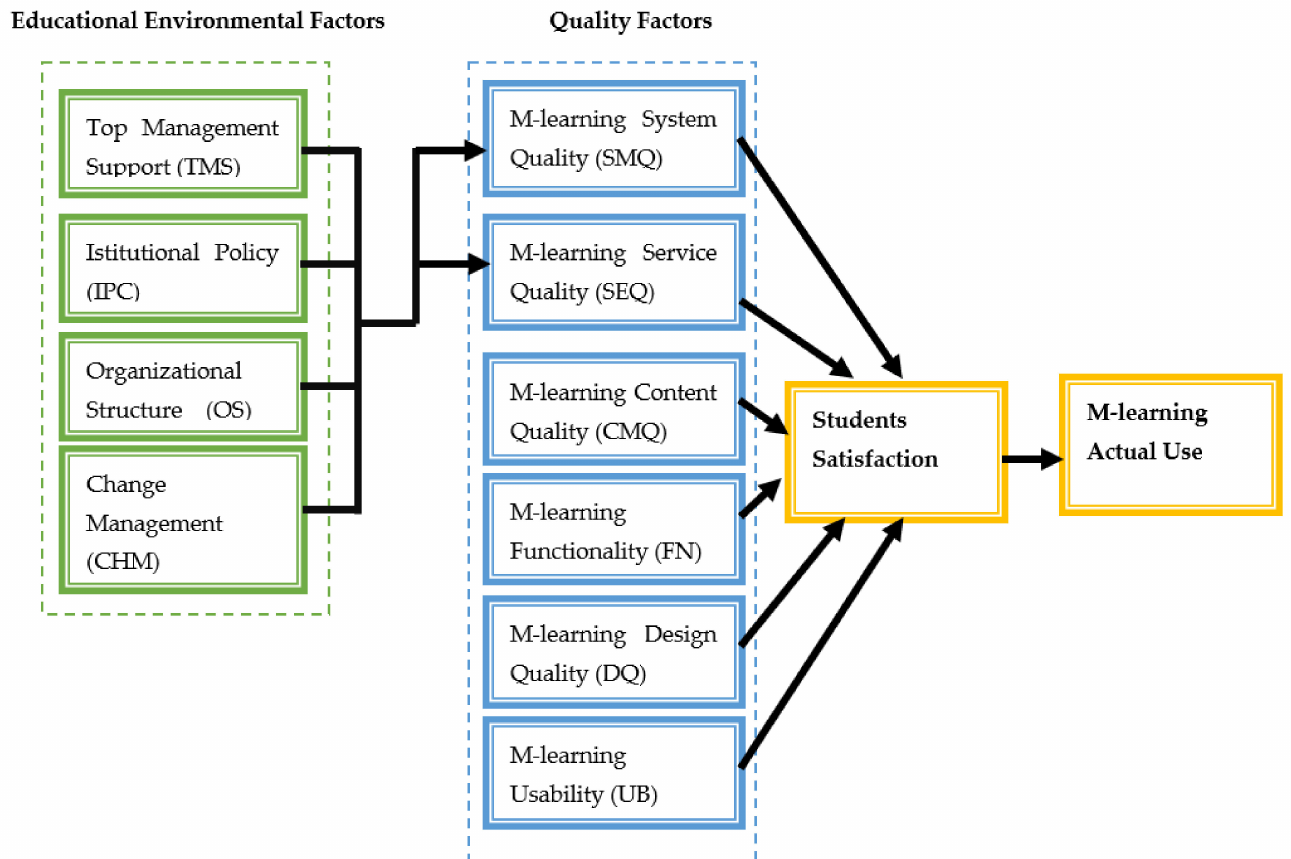
Figure 3. The Proposed